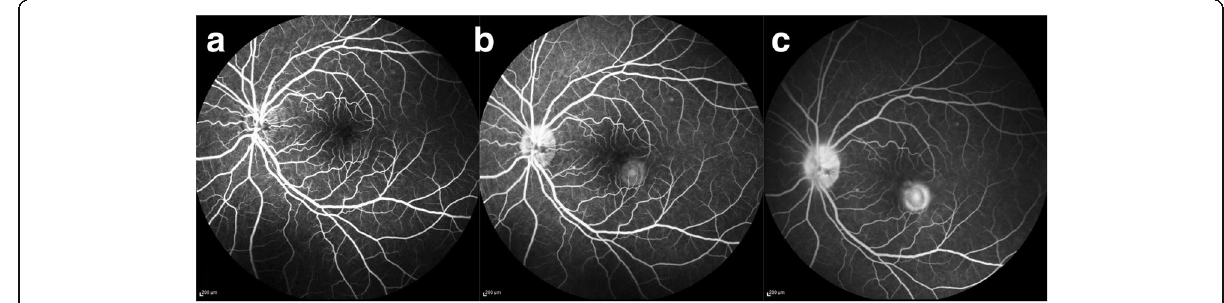
Fig. 2 Fundus fluorescein angiography of the left eye showing a no obvious leakage in the early phase, b faint hyperfluorescence in the mid phase, and c intense hyperfluorescence with leakage in the late